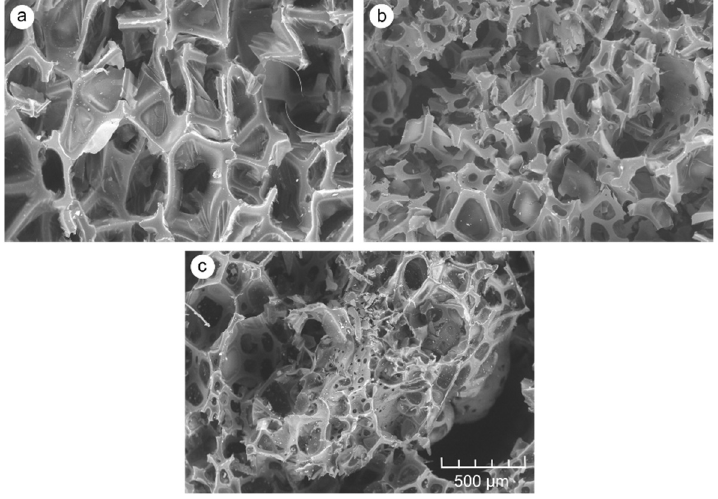
Figure 9. SEM images of PUR samples: ( a ) control sample; ( b ) 10% WP addition; ( c ) 15% WP addition. All scale bars of figures are the same.